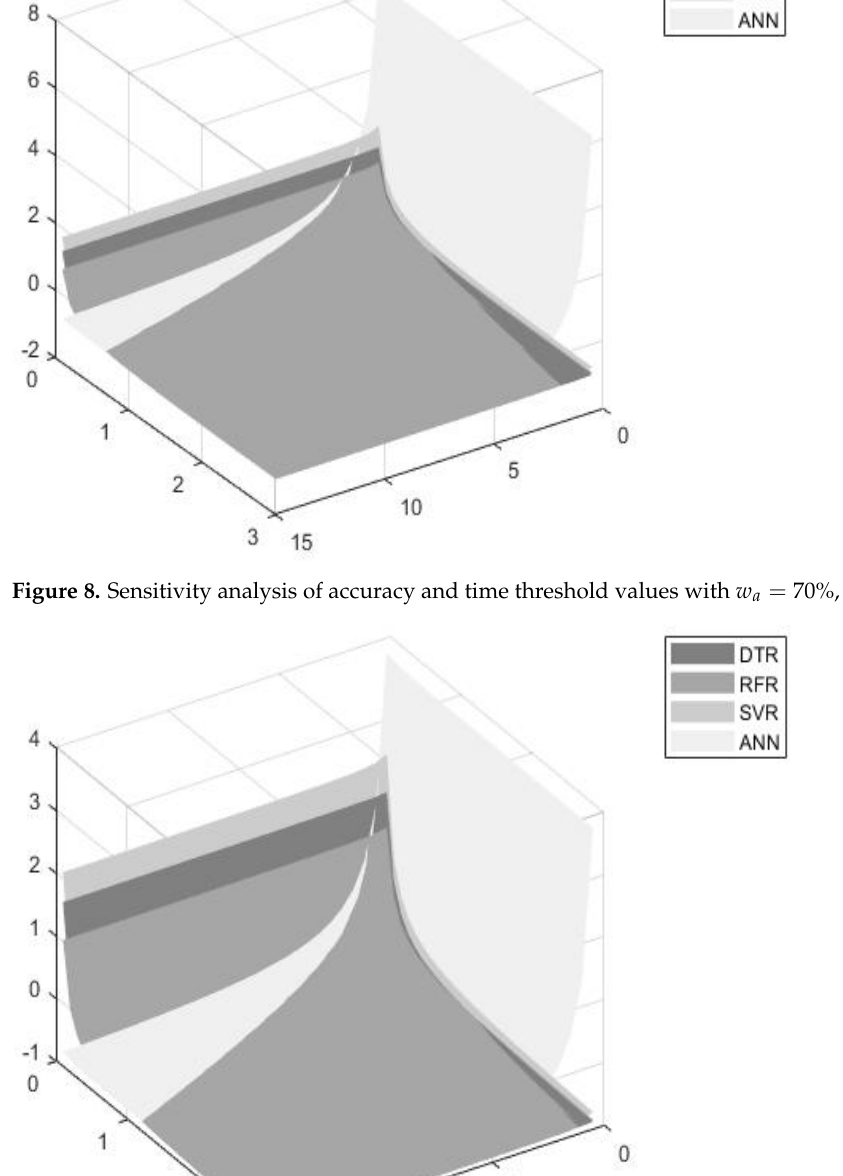
Figure 9. Sensitivity analysis of accuracy and time threshold values with w a = 80%, 1 − w a = 20%